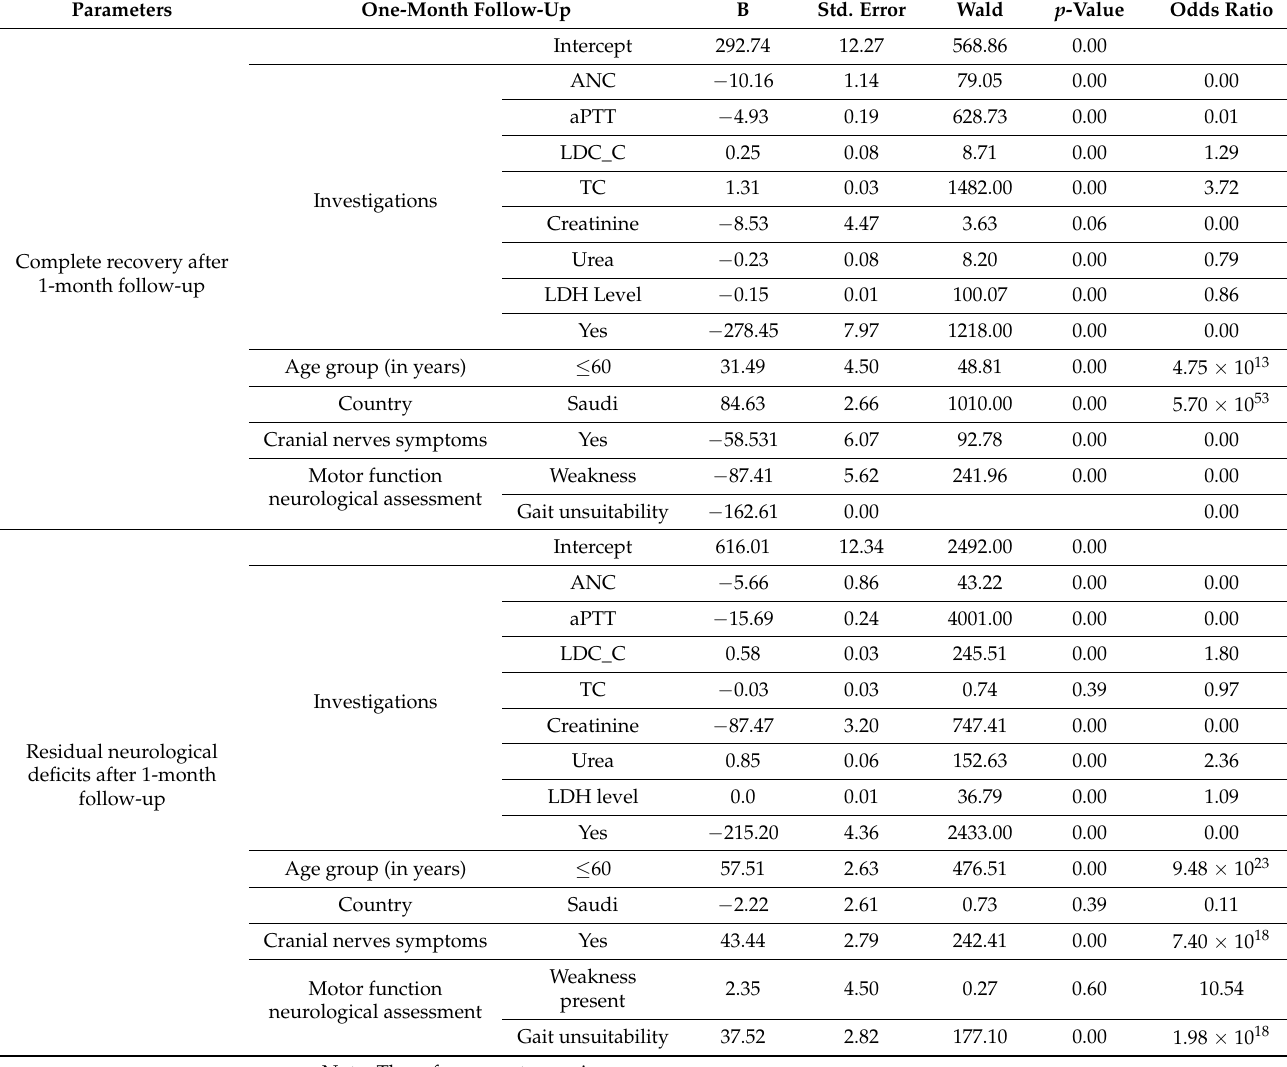
Figure 1 represents the onset of neurological symptoms among COVID-19 patients. The onset of neurological symptoms in the majority of patients (45%) was shown to be between 3 days and 10 days and in 26% of patients, symptoms developed between 10 days and 14 days after their COVID-19 diagnosis. Only 12% of patients developed neu- rological symptoms after 14 days of COVID-19 diagnosis.